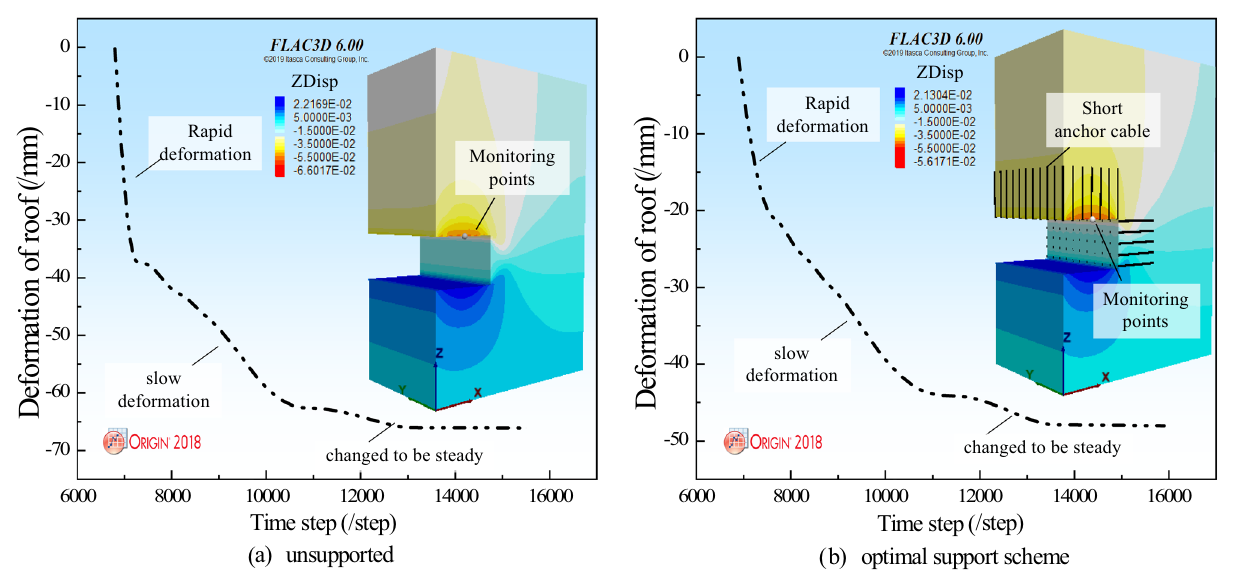
Figure 9. Comparison of displacement fields of two sides of surrounding